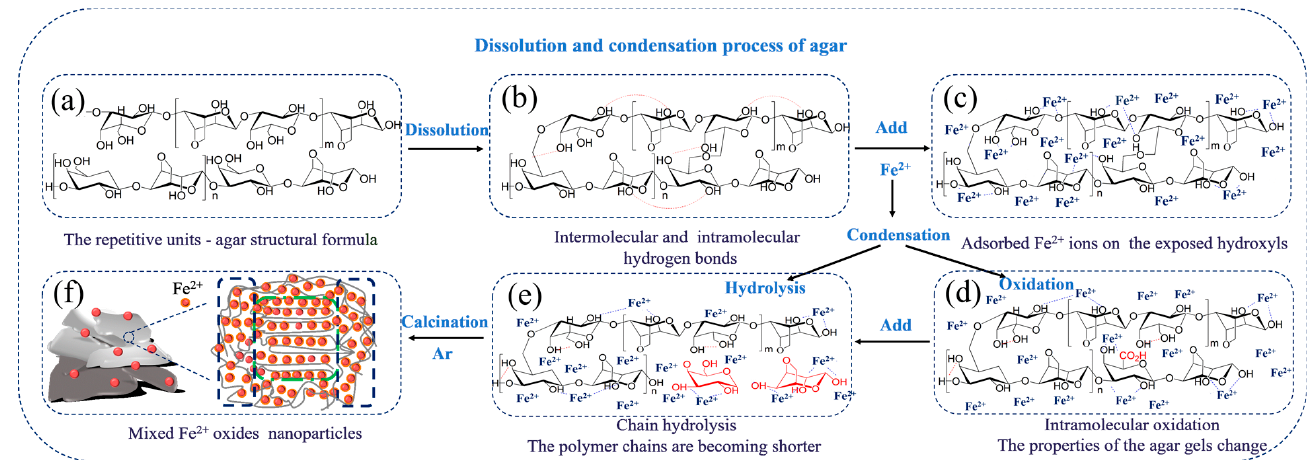
Figure 3. Schematic diagram of the condensation as agar soft template. ( a ) the agar structure before dissolution ( b ) the agar structure after dissolution into water ( c ) the agar structure after adding the adsorbed Fe 2+ ( d ) the oxidation process of agar structure ( e ) the hydrolysis process of agar structure ( f )the schematic diagram of Fe oxides and the atom sort order of Fe.